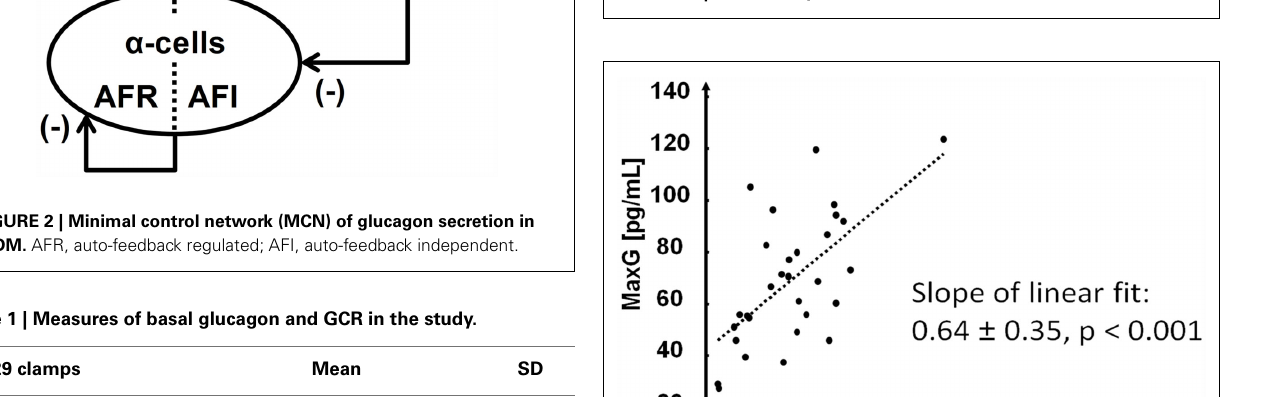
FIGURE 3 | Relationship between GL basal and CumG 90 .